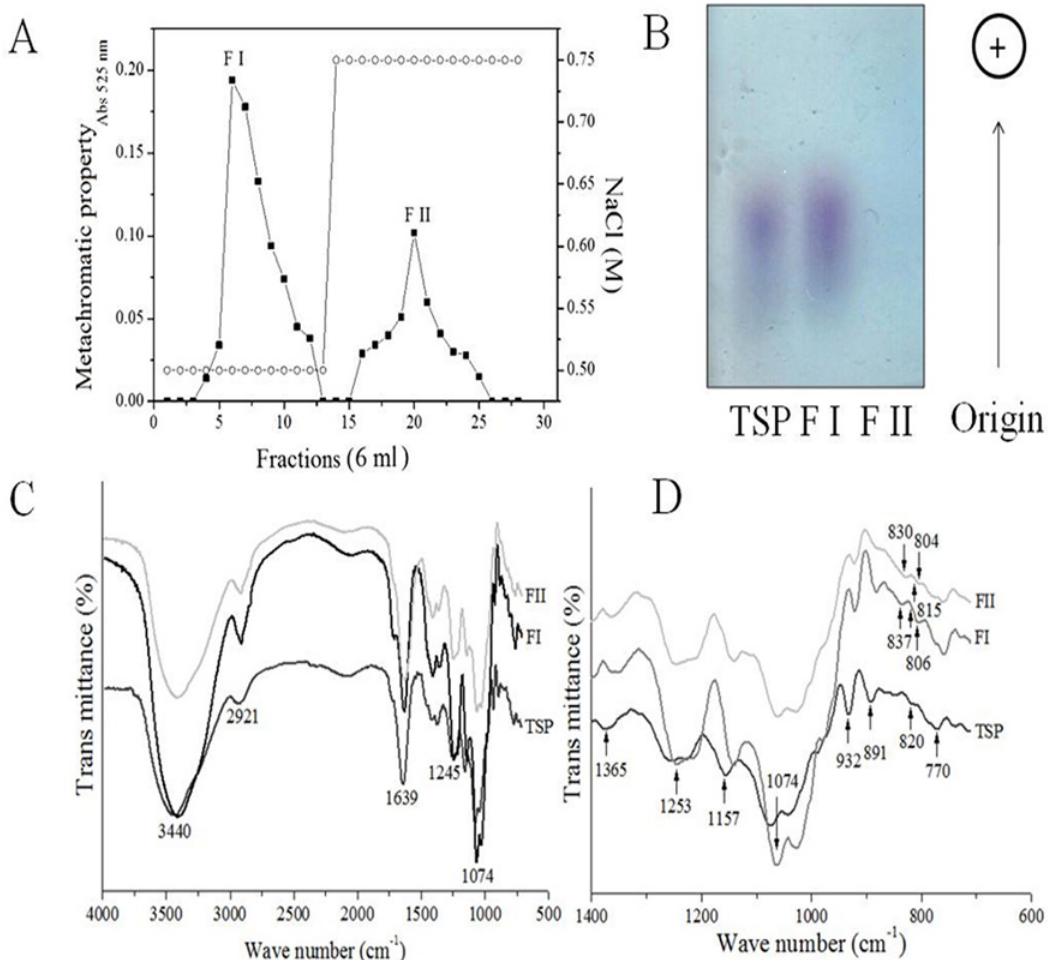
Fig 1. Separation of Gc-TSP by DEAE-cellulose (Fractions Gc-FI and Gc-FII). Metachromasia ( & — & ) and NaCl concentrations ( (cid:2) — (cid:2) ) (A). Agarose gel electrophoresis (B) and FT-IR spectra at 500 and 4000 cm -1 (C and